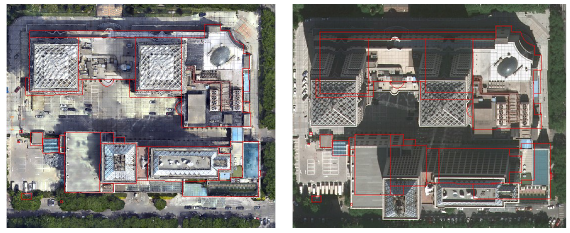
Figure 2. TDOM and